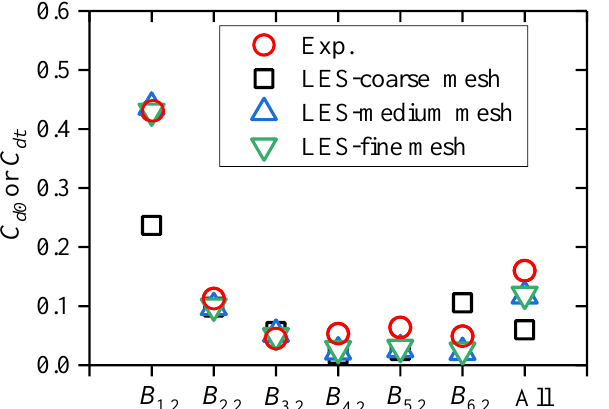
Figure 12. Comparisons of C d 0 for six pressure models C 2 and C dt in DWP among wind tunnel experiments and LES meshes.